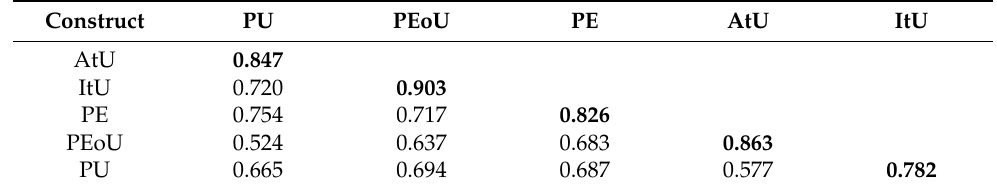
Table 7. Discriminant validity matrix (Fornell–Larcker